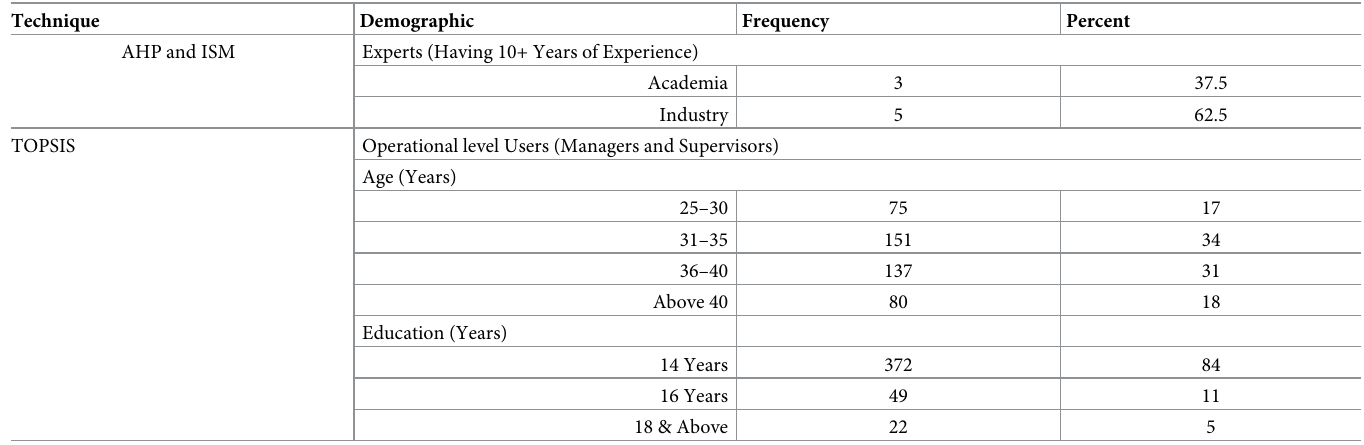
Table 1. Demographics of the